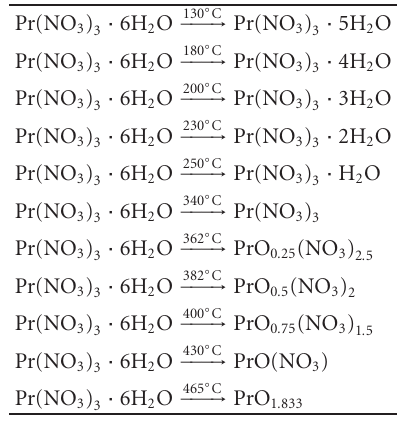
Table 2: Pathway for the thermal decomposition of praseodymium nitrate in air. Reproduced from Thermoch. Acta , 2001, 369 , 59. Copyright 2001, Elsevier